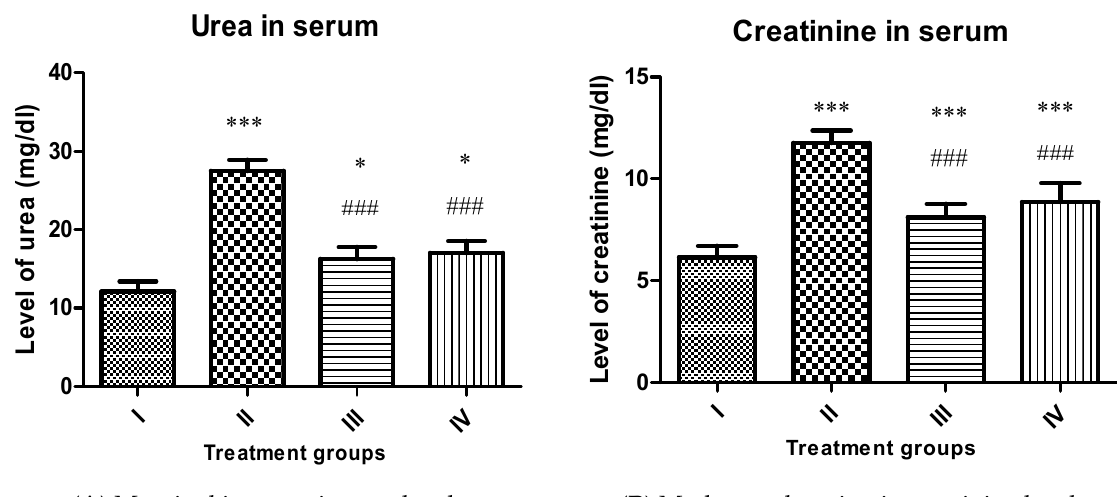
Figure 7. Showing bars of renal function markers (Urea ( A ) and Creatinine ( B )) of the indicated groups. All the data has been expressed in mean ± SEM for each group. * indicates statistically different from the control (group I) at p ≤ 0.05 while # indicates statistically different control positive (group II). Also ** and ## indicate p ≤ 0.005 while *** and ### indicate p ≤ 0.001.